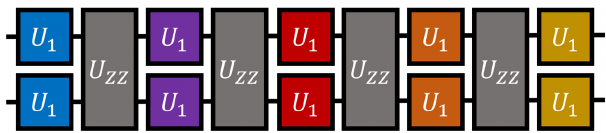
FIG. 1. The elements of the benchmarking group G are con- structed by composing elementary gates as shown above to implement elements of G T on the triplet subspace. Each group element contains exactly four entangling gates.